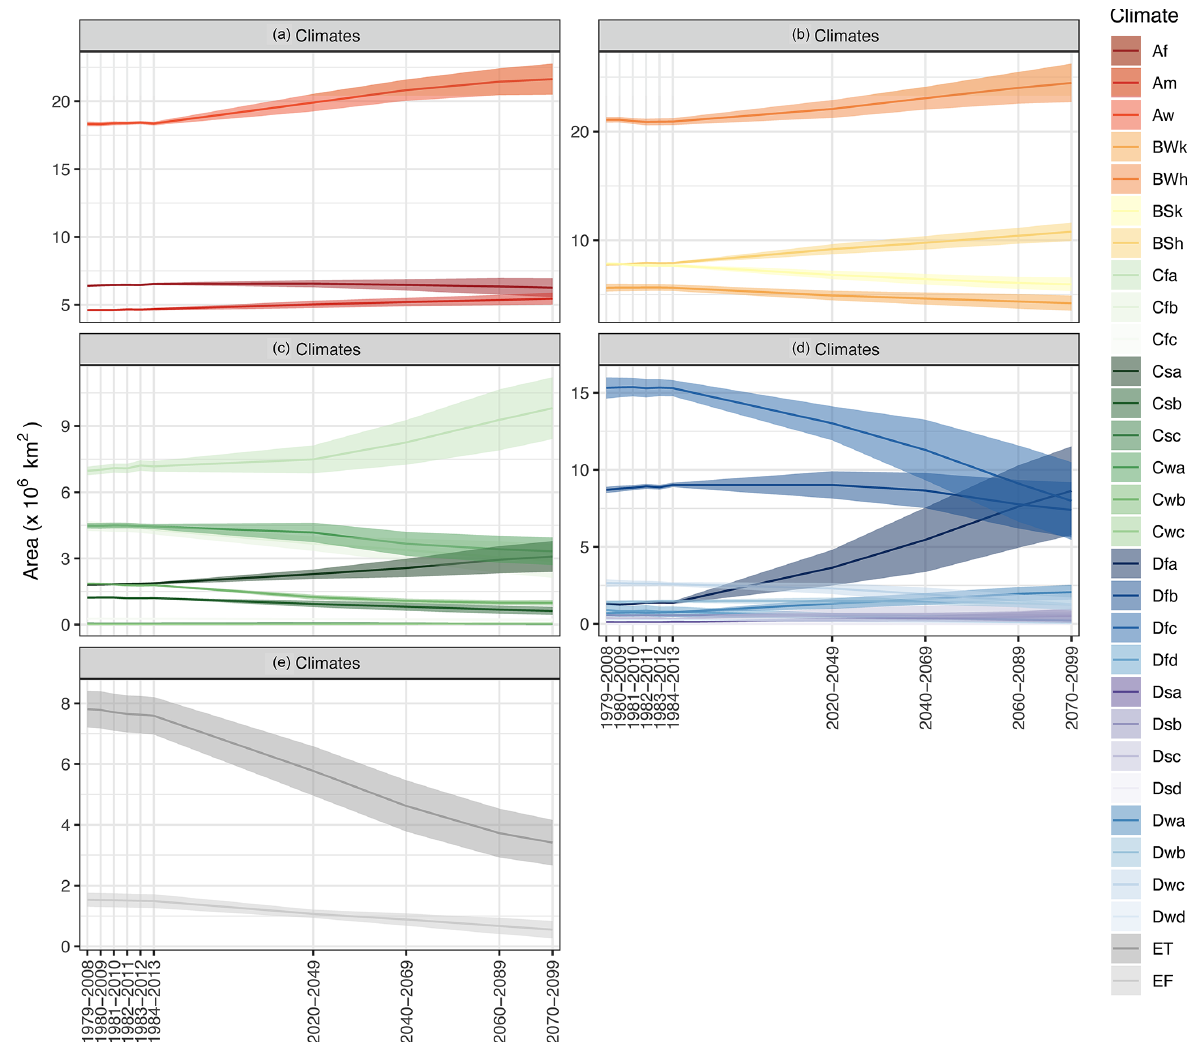
Figure 14. Area changes in climate zones since the 1980s on a global scale under RCP8.5. The error bars for historical periods (1979–2014) indicate standard error in the Köppen–Geiger classification results based on the nine combinations of observational air temperature and precipitation datasets and for future periods (2020–2099); the error bars indicate standard error in the Köppen–Geiger classification results based on the 30